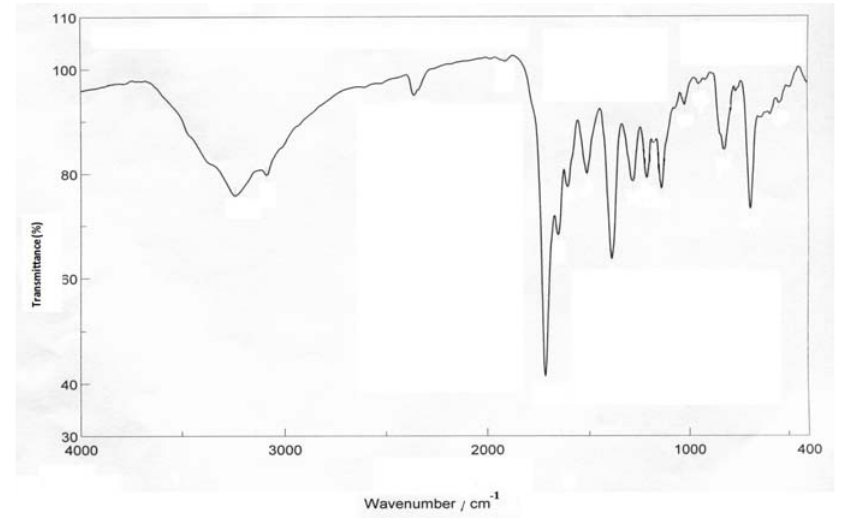
Figure 1. FTIR spectrum of